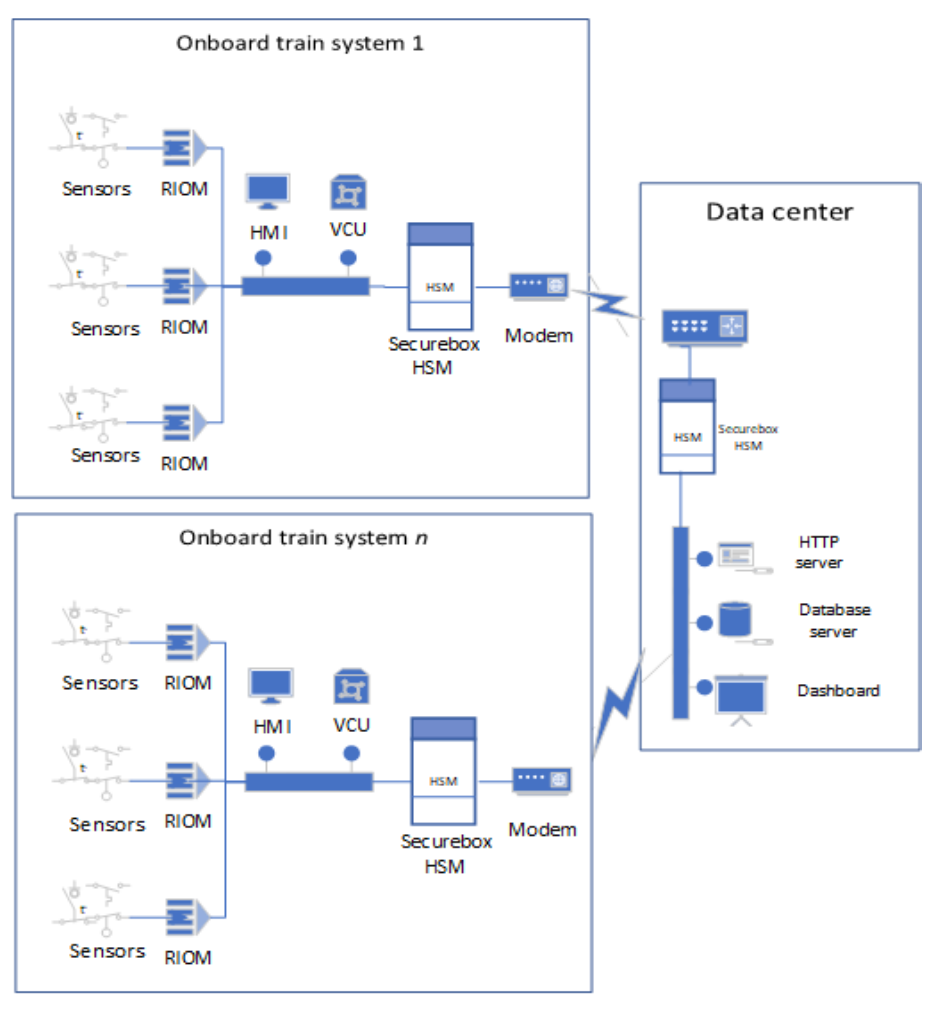
Figure 2. Secure TCMS